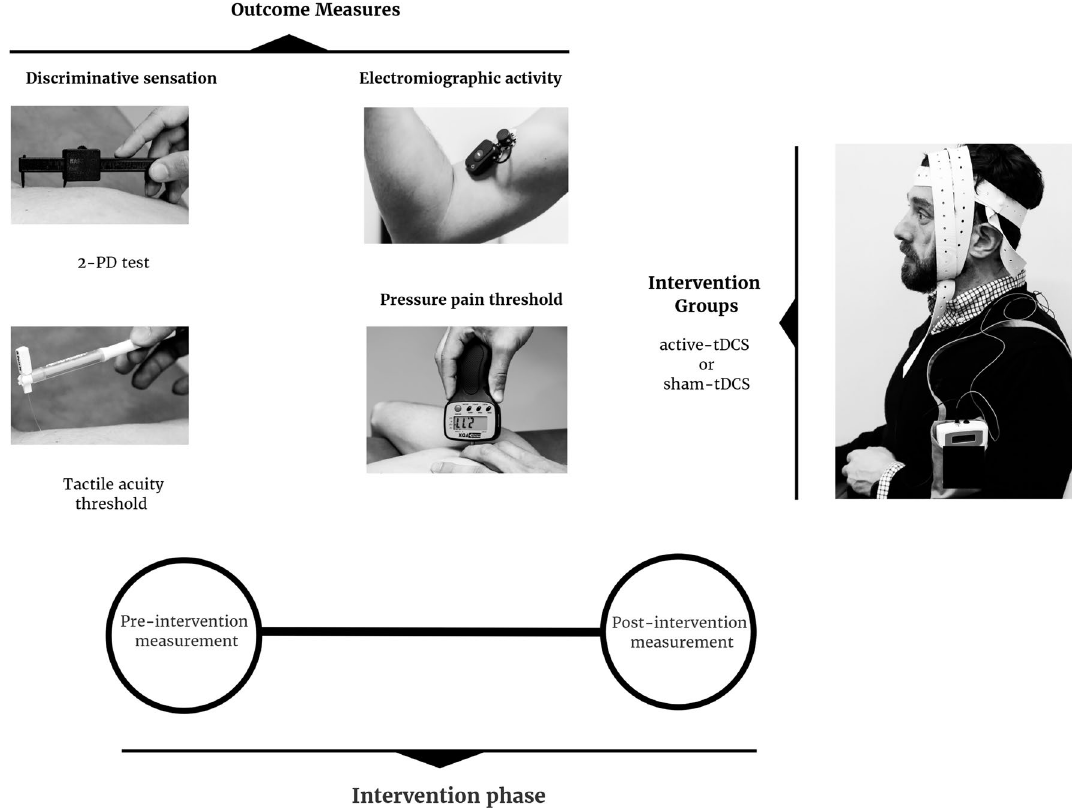
Figure 2. Representation of intervention and the